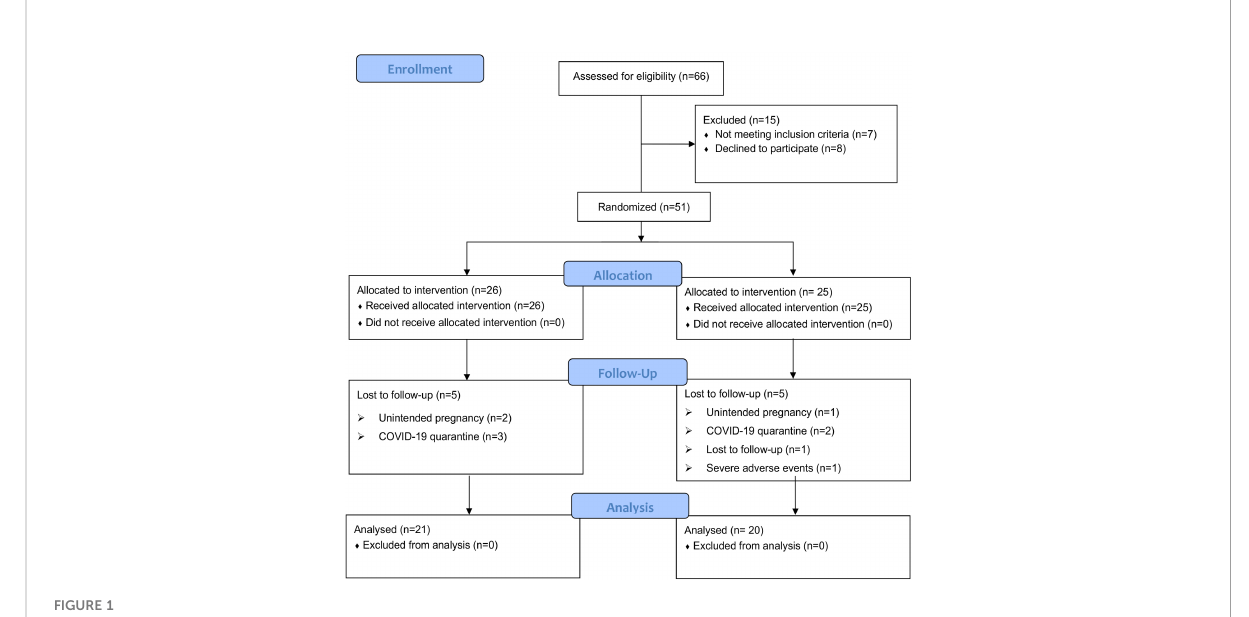
FIGURE 1 Patient selection fl ow